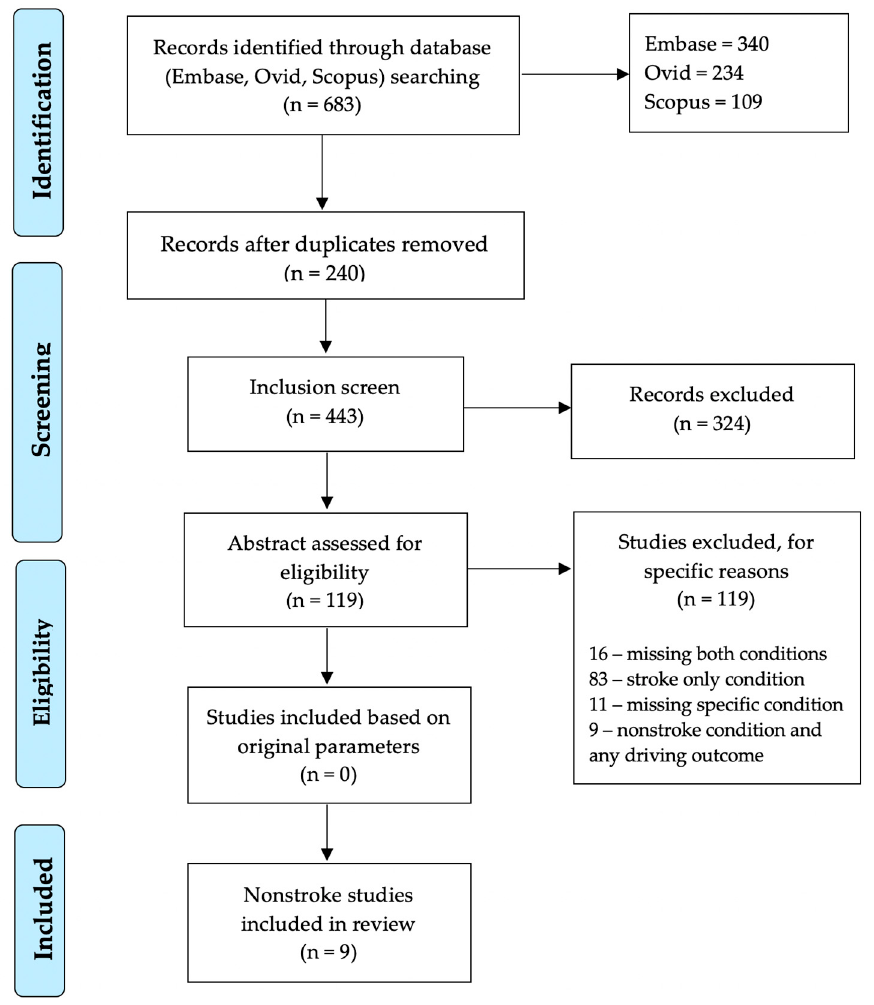
Figure 1. PRISMA flow diagram of studies included in review.